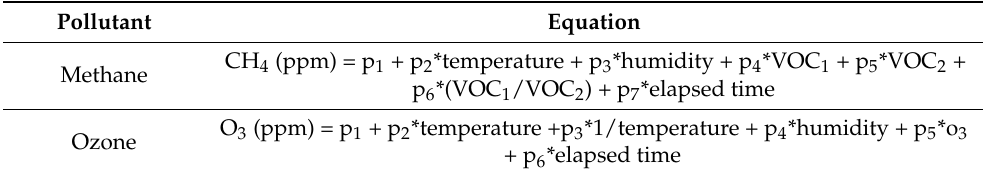
Table 2. Linear Calibration